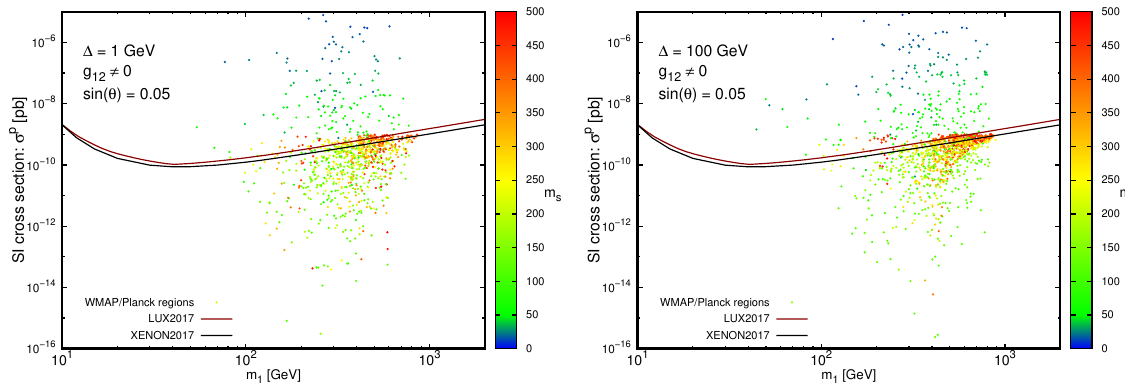
Figure 8 . The DM-proton (SI) scattering cross section as a function of DM mass for the mass split- ting (cid:1) = 1 GeV (left) and (cid:1) = 100 GeV (right) . The singlet scalar mass is 10 GeV < m s < 500 GeV and the mixing angle is sin (cid:18) = 0 : 05. The couplings are chosen as (cid:0) 1 < g 1 ; g 2 ; g 12 < 1.